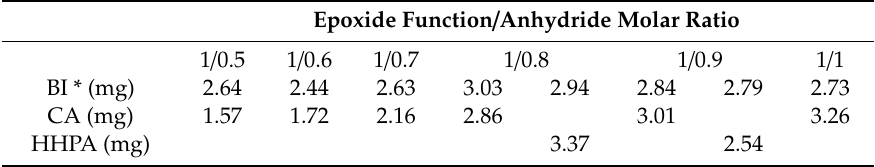
Table 1. Formulation of the studied samples.